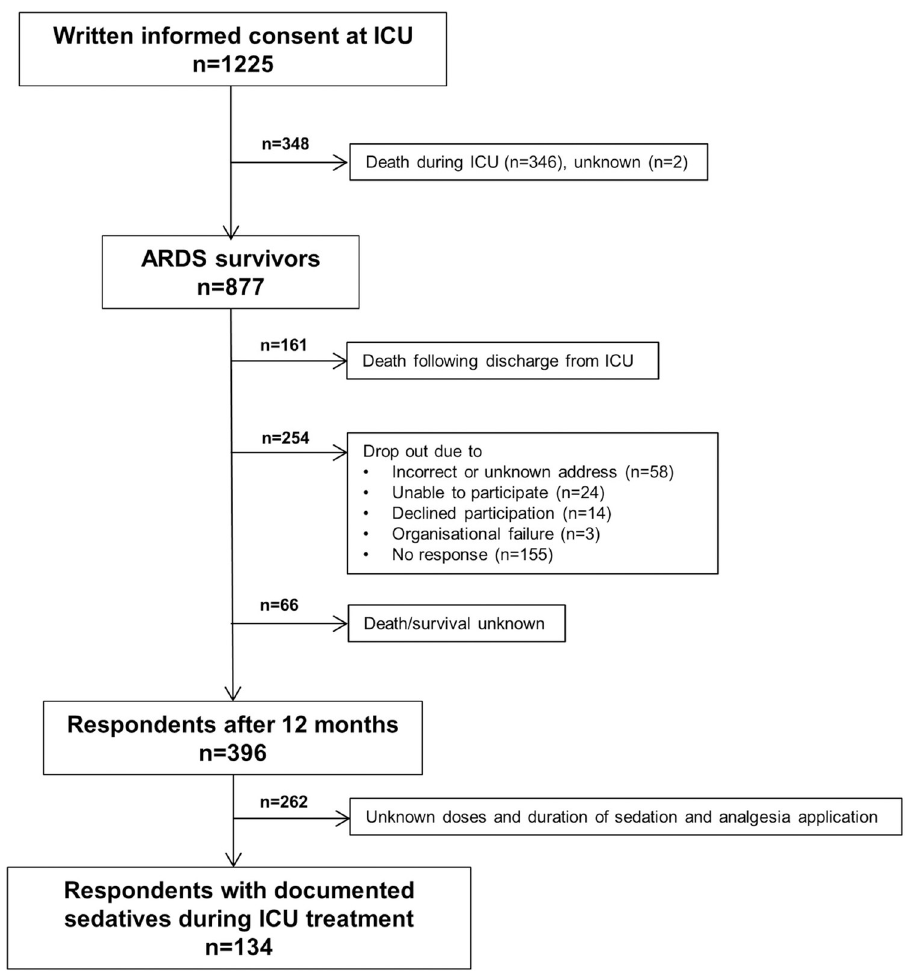
Fig 1. Flow chart of patients with ARDS throughout the